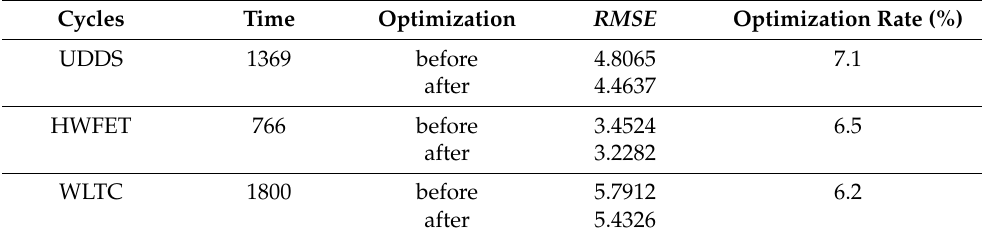
Table 5. The comparison of predictive accuracy (prediction time = 5 s).